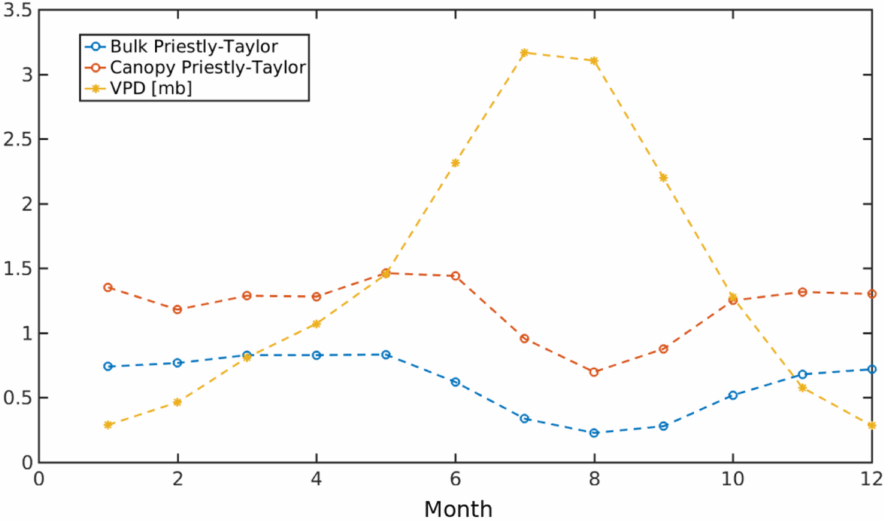
Figure 9. α PT bulk estimations vs. VPD over Las Majadas for 2007–2011